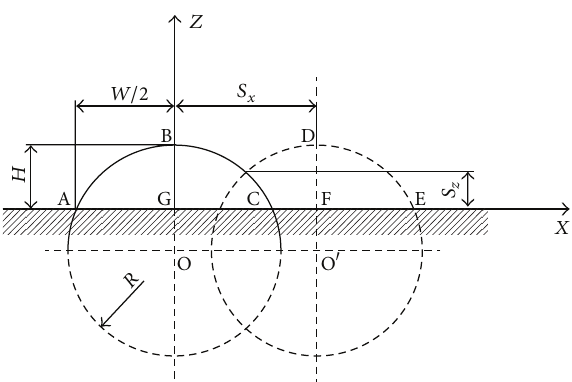
Figure 3: Graphic representation of the mathematical model to calculate the optimal 𝑂 %